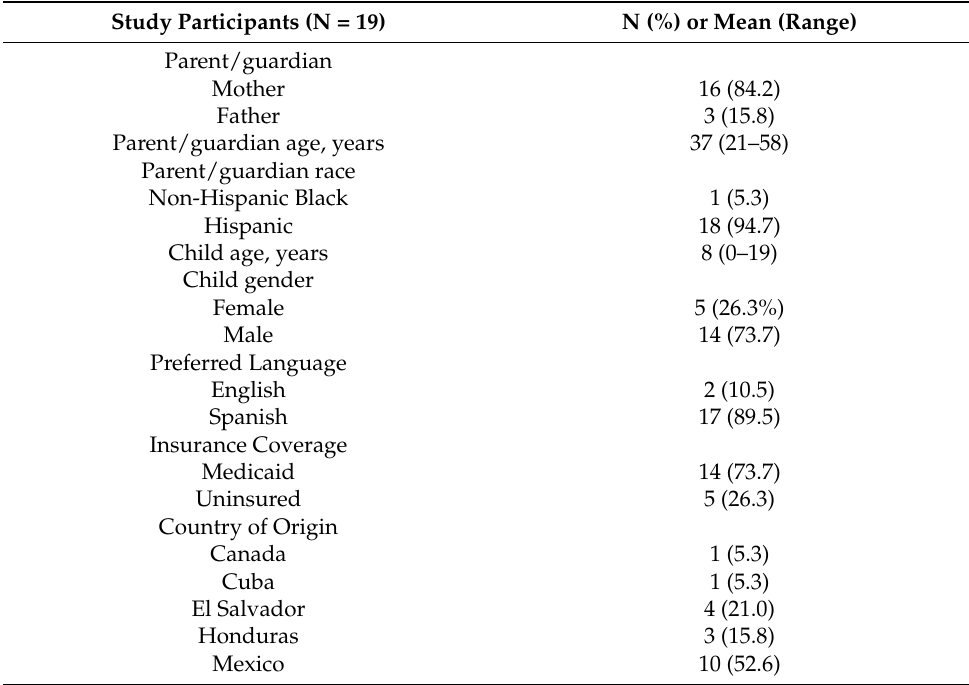
Table 1. Legal Needs Screening Participant